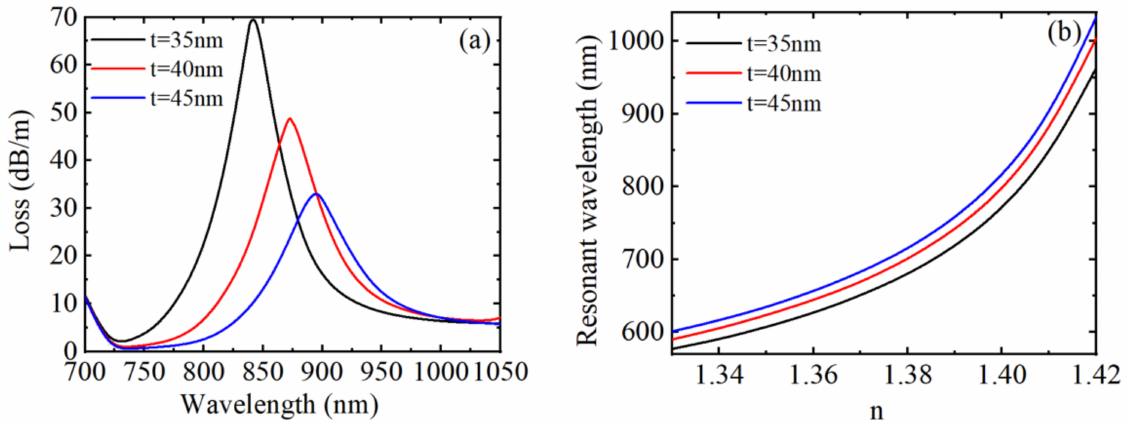
Figure 9. ( a ) The loss spectrum of the core guide mode under different metal nano-film thicknesses. ( b ) The variation relationship between the resonance wavelength and n .